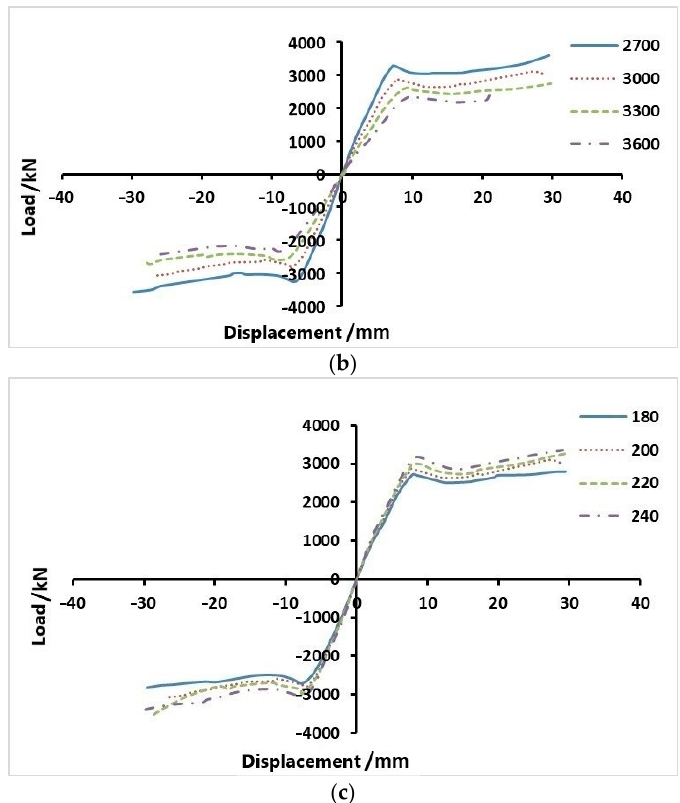
Figure 17. Skeleton curves under different parameters. ( a ) Different axial compression ratios. ( b ) Different height-width ratios. ( c ) Different sizes of end column.